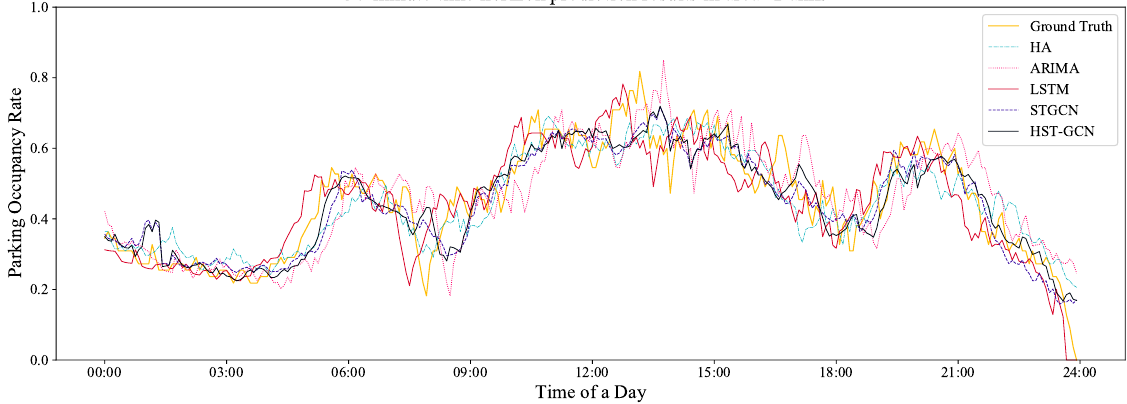
Figure 8. The prediction of a randomly selected area with a 30-min time horizon.